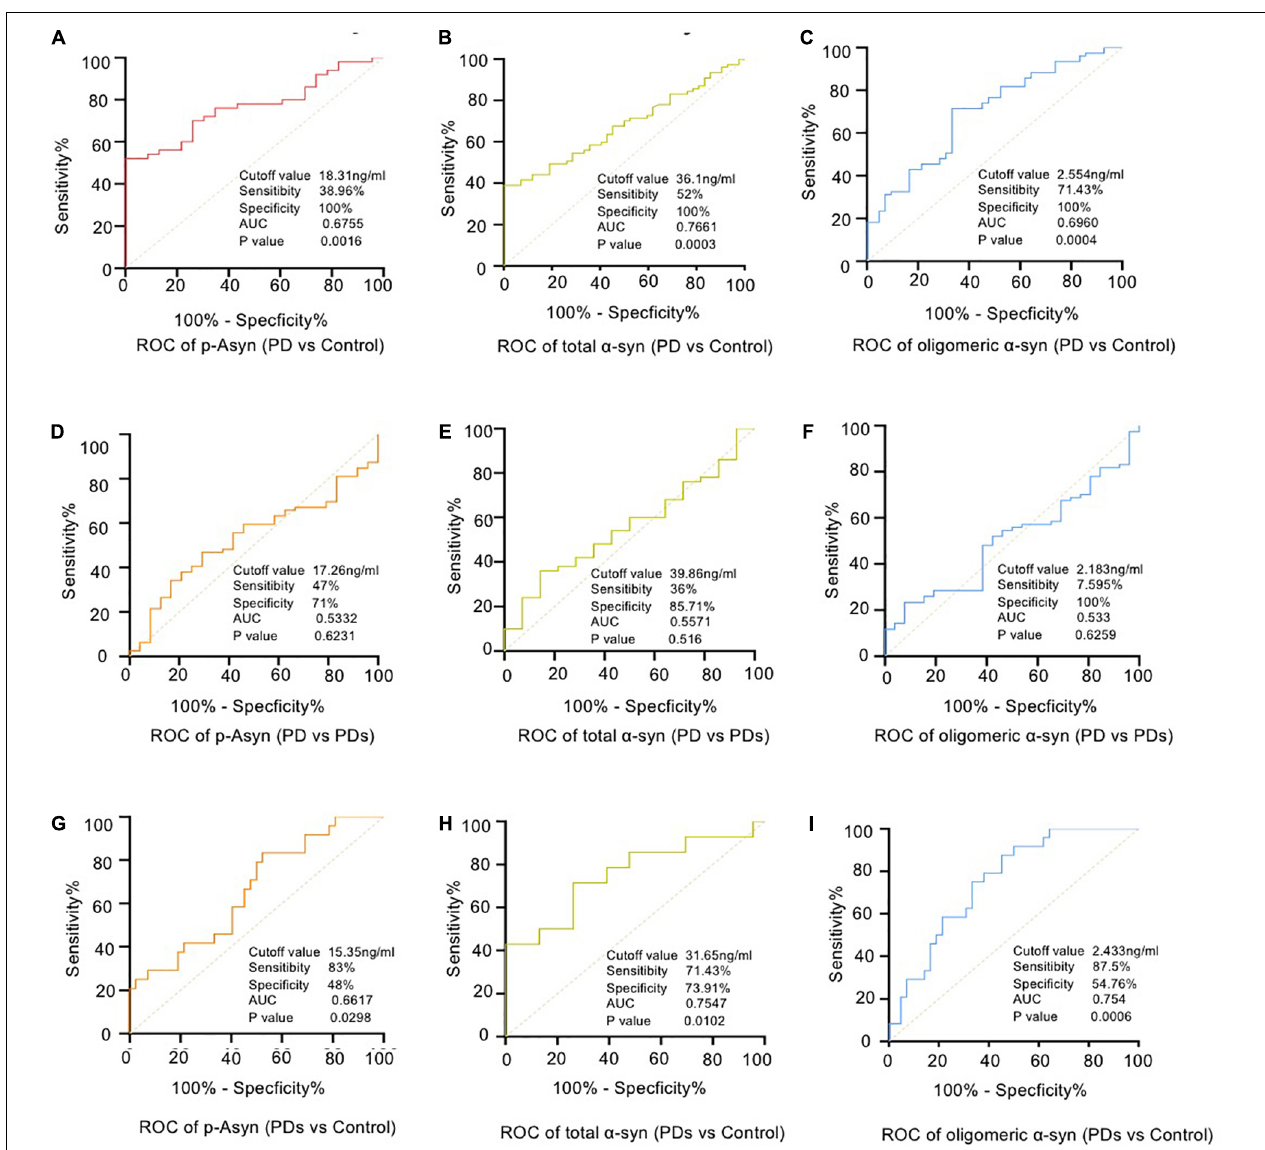
FIGURE 3 | Receiver operating characteristic (ROC) curve analyses for differentiating between PD vs HCs (A–C) , PD vs PDs (D–F) and PDs vs HCs (G–I) . PD = Parkinson’s Disease; PDs = Parkinsonian syndrome; HCs = Healthy